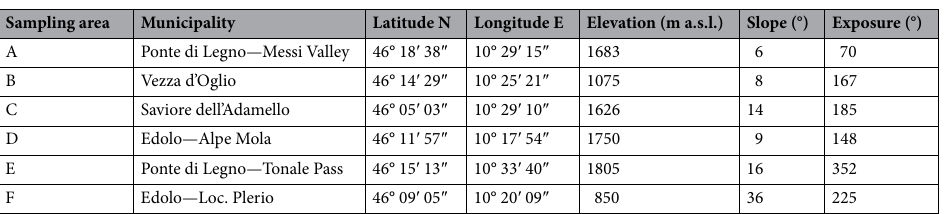
Table 1. - Location of the six production/sampling